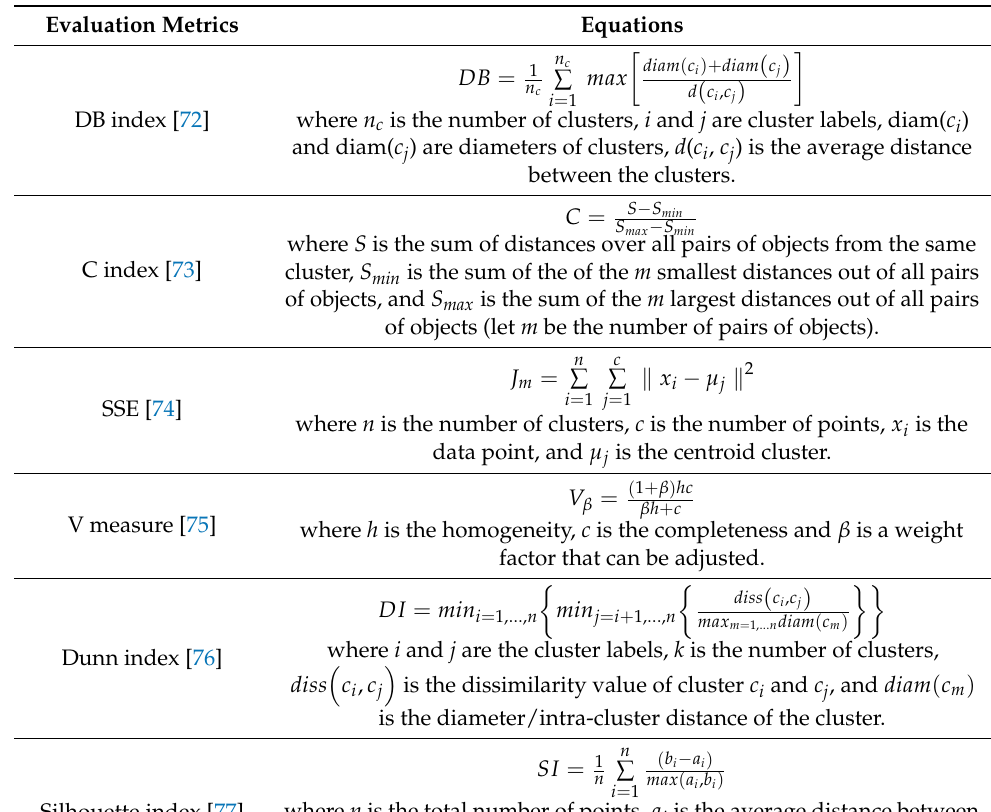
Table 3. Evaluation metrics and